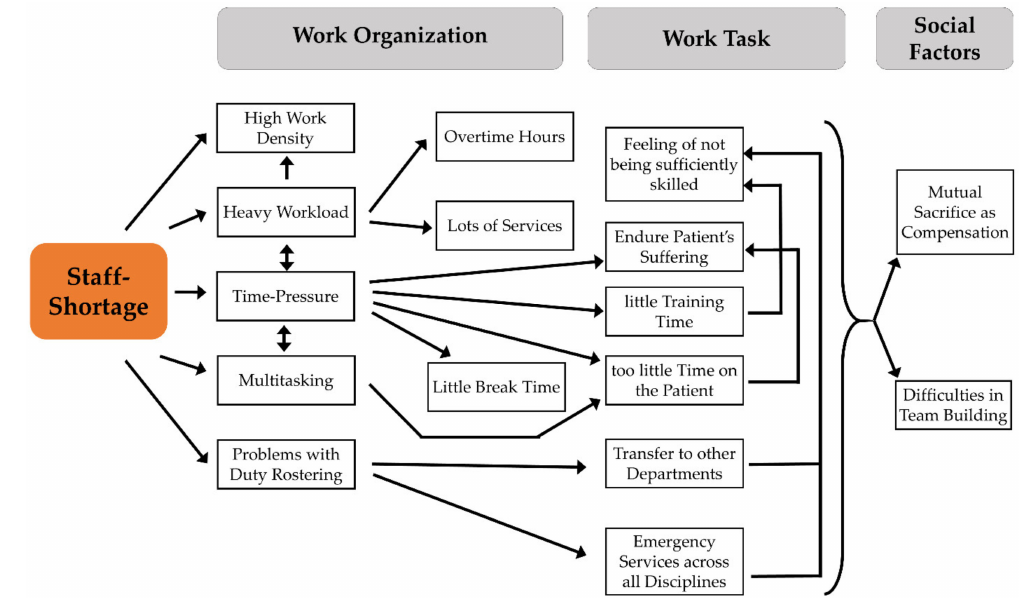
Figure 4. Graphical representation of hospital managers perceptions of the e ff ect of sta ff shortage on further stressors relating to work organization, work task, and social factors according to the hospital